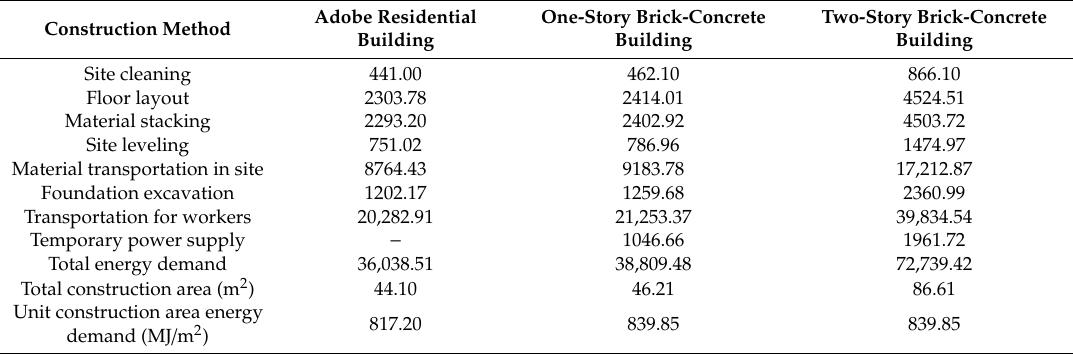
Table 5. Energy demand list for the building erection process for di ff erent residential buildings (MJ).